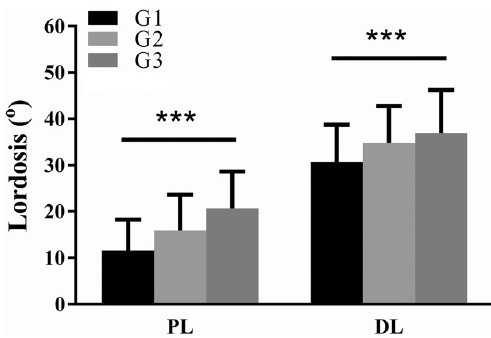
Figure 1. Bar chart of values of proximal lumbar lordosis and distal lumbar lordosis in the three pelvic incidence groups.